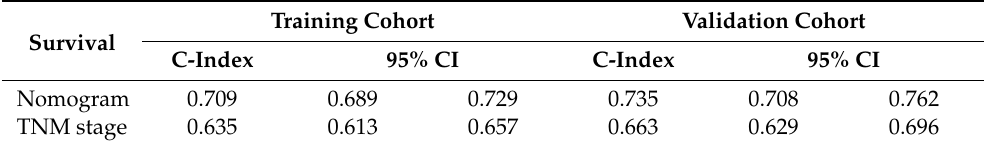
Table 3. C-indexes for the nomograms and TNM stage.